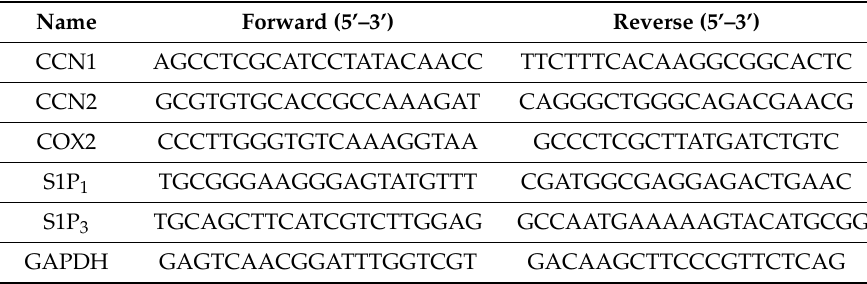
Table 1. Sequences of primer for RT-qPCR used in this